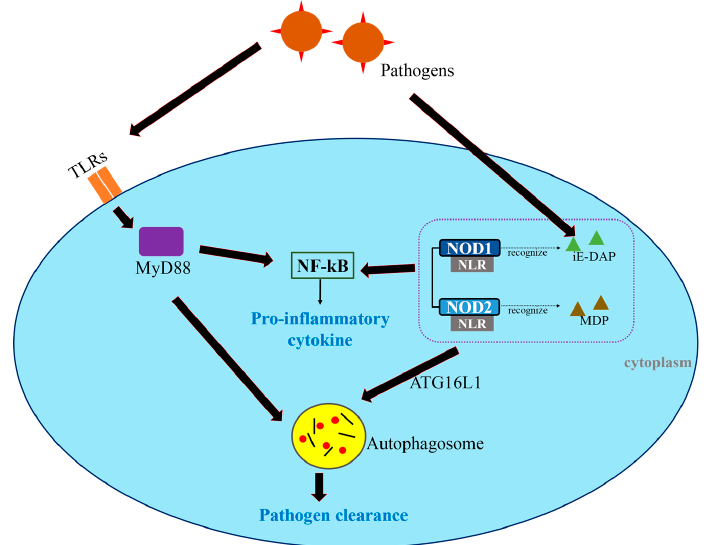
Figure 2. Toll-like receptors (TLRs) and Nod-like receptors (NLRs) regulate autophagy and the innate